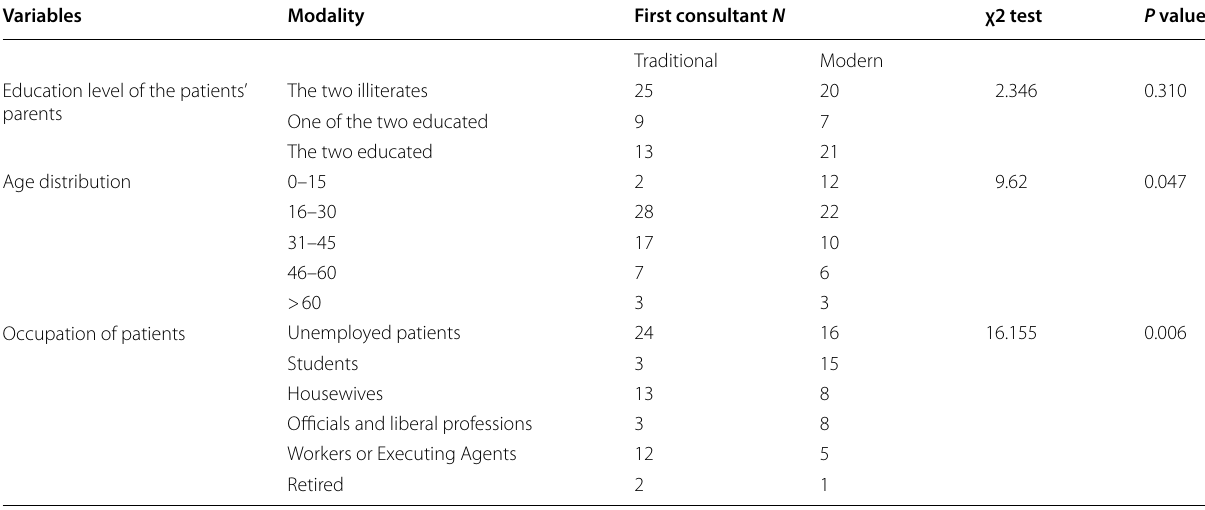
Table 3 The relationship between the first consultant and socio-demographic and cultural characteristic in patients with epilepsy Variables